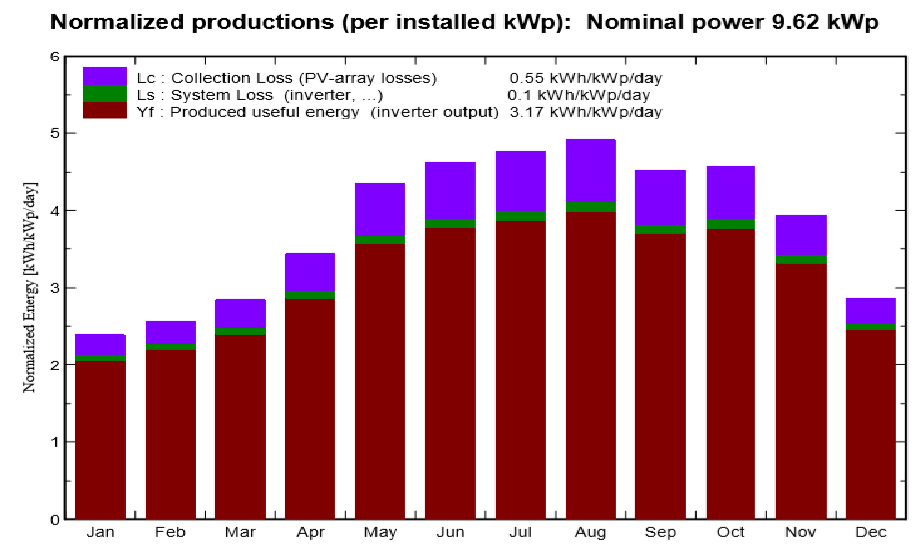
Figure 8. Monthly electricity of simulation results according to Meteonorm data. Table 2. The simulation results according to Meteonorm data.